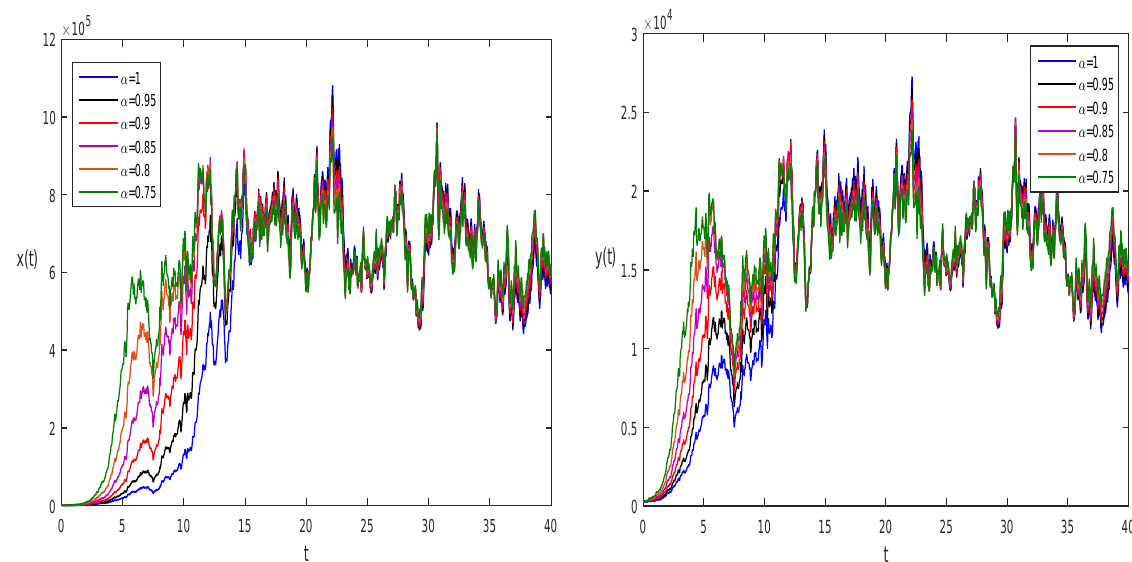
Figure 7. Unique solution of fractional stochastic model in Equation (30) for different fractional parameter